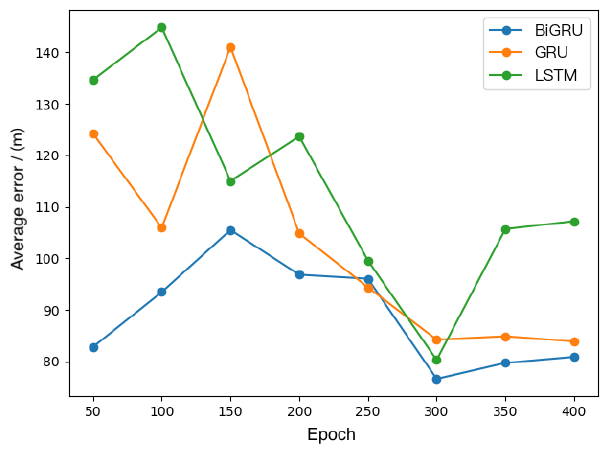
Figure 18. Comparison of prediction errors between BiGRU, GRU and LSTM.